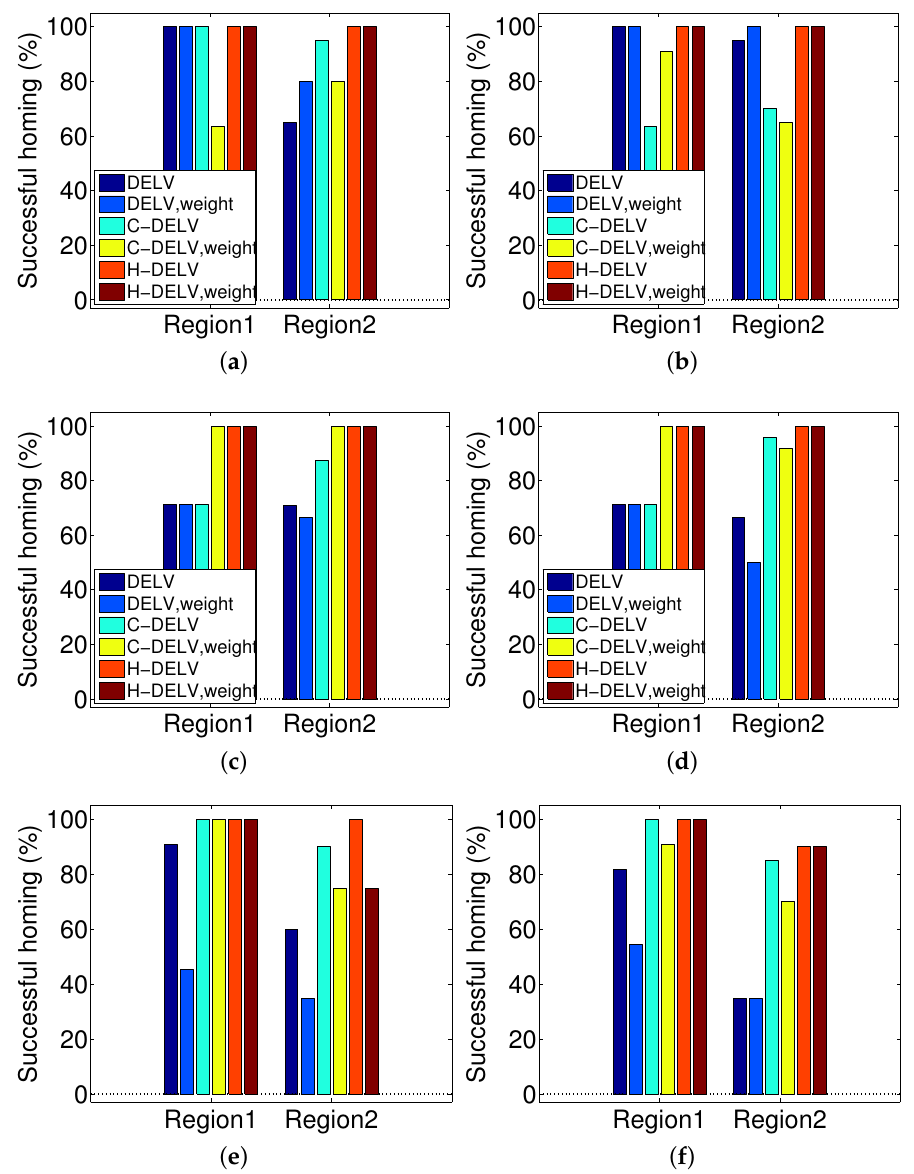
Figure 11. Success rate of homing for three different methods in Regions 1 and 2 ( left : with the reference compass, right : without the reference compass); ( a , b ) env1; ( c , d ) env2; ( e , f )